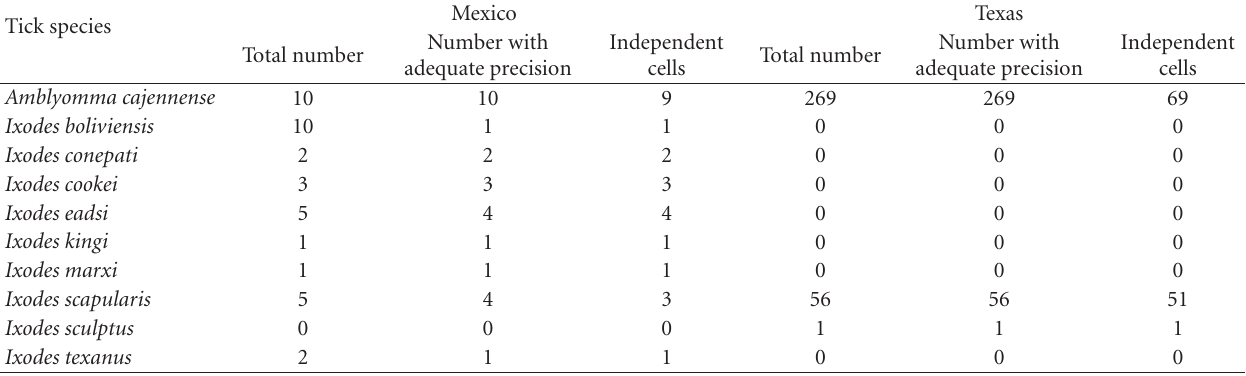
Table 1: Total number of records and final number of records used to generate the analysis. Tick species